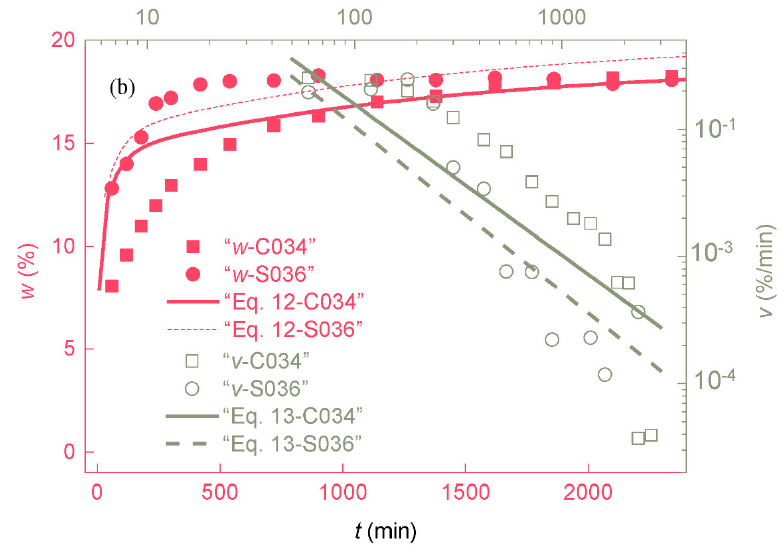
Figure 10. Comparison between the soft rock water absorption prediction model and natural rock water absorption process. ( a ) Natural hard rock; ( b ) Natural soft rock.